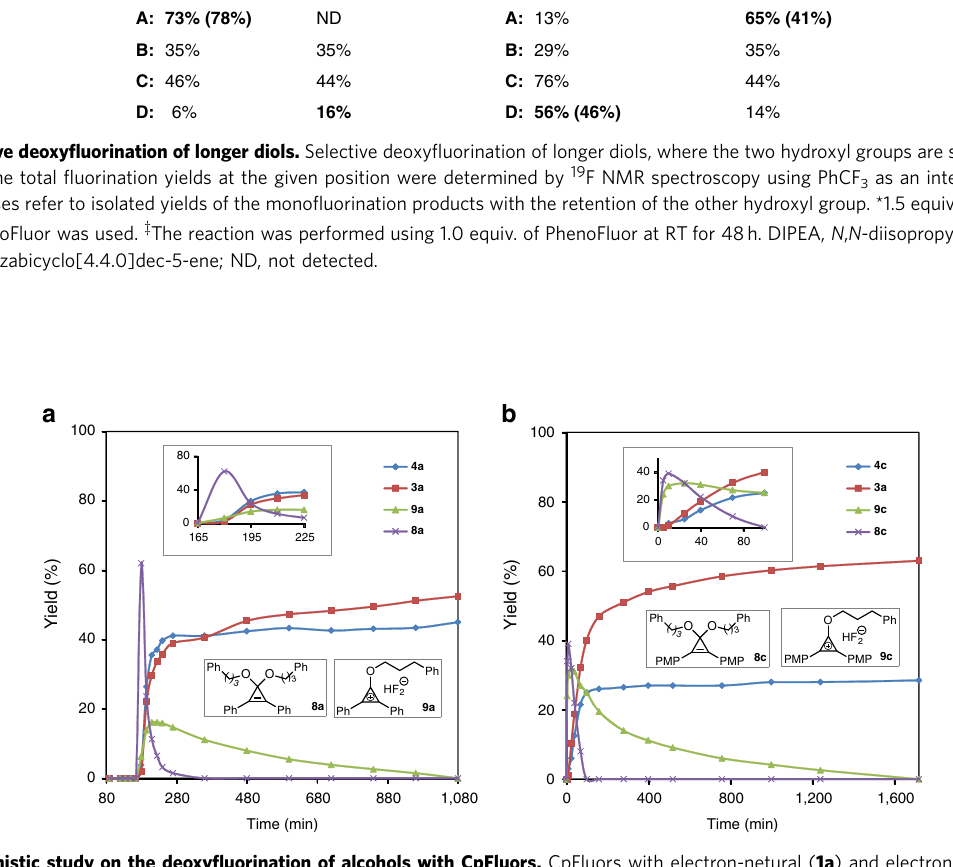
Figure 5 | Mechanistic study on the deoxyfluorination of alcohols with CpFluors. CpFluors with electron-netural ( 1a ) and electron-rich ( 1c ) aryl substitutents were chosen to monitor the influence of electronic nature on the chemical outcome. Both reactions were perforformed in PTFE NMR tubes with DCE- d 4 as the solvent. ( a , b ) Yield profiles of products and intermediates generated in the reactions of 3-phenylpropan-1-ol ( 2a , 1.0 equiv.) ( a , b ) with CpFluors 1a (1.0 equiv.) ( a ) and 1c (1.0 equiv.) ( b ) during the whole monitoring process. Insets on the top ( a , b ): the enlarged yield profiles at the early stage of the reactions. PMP, p -methoxyphenyl.